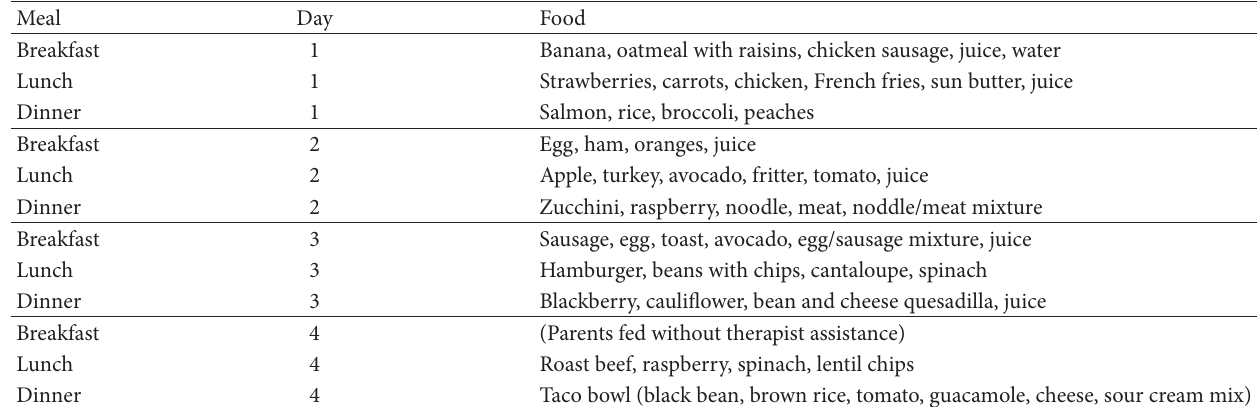
Table 2: New foods